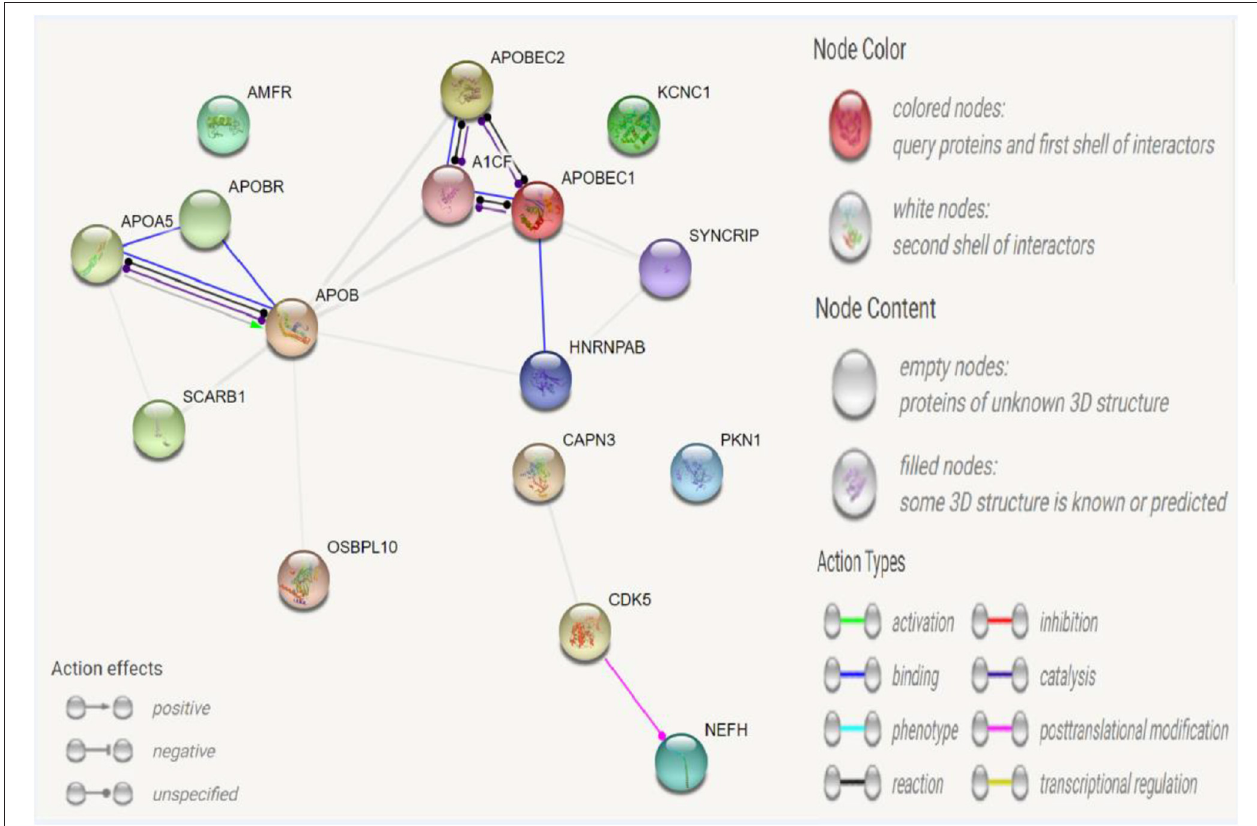
FIGURE 2 | Network for KCNC1, CAPN3, NEFH, APOB, and their interacted genes. Network nodes represent proteins. Splice isoforms or post-translational modifications are collapsed, i.e., each node represents all the proteins produced by a single, protein-coding gene locus. Edges represent protein-protein associations: associations are meant to be specific and meaningful, i.e., proteins jointly contribute to a shared function; this does not necessarily mean they are physically binding each other. mutation has a negative effect on the Kv3.1 channel by producing